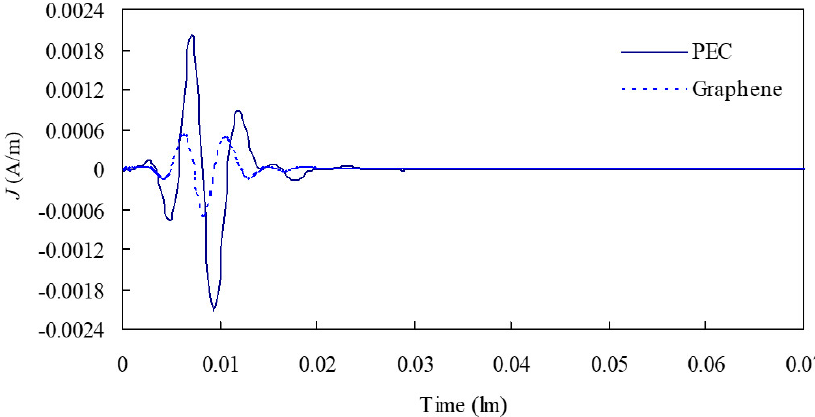
Figure 1. Graphene’s surface impedance: ( a ) real parts; ( b ) imaginary parts.